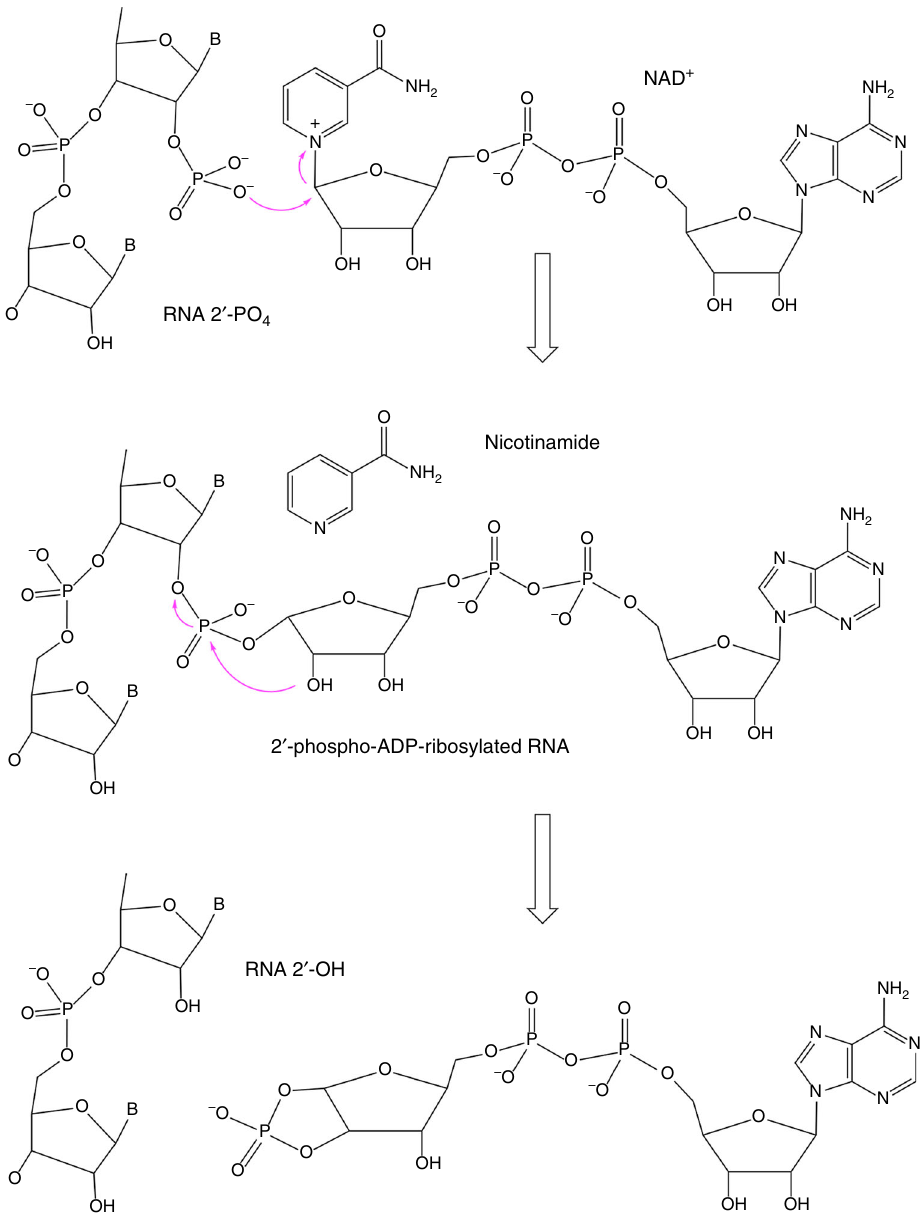
Fig. 1 Two-step Tpt1-catalyzed mechanism of 2 ′ -PO 4 removal from a 2 ′ -PO 4 , 3 ′ -5 ′ phosphodiester RNA junction. The Tpt1 reaction pathway comprises the two chemical steps shown in which: (1) the RNA 2 ′ -PO 4 reacts with NAD + to expel nicotinamide and form a 2 ′ -phospho-ADP-ribosylated RNA intermediate; and (2) transesteri fi cation of the ADP-ribose 2 ′′ -OH to the RNA 2 ′ -PO 4 displaces the RNA 2 ′ -OH and generates ADP-ribose-1 ″ ,2 ″ -cyclic